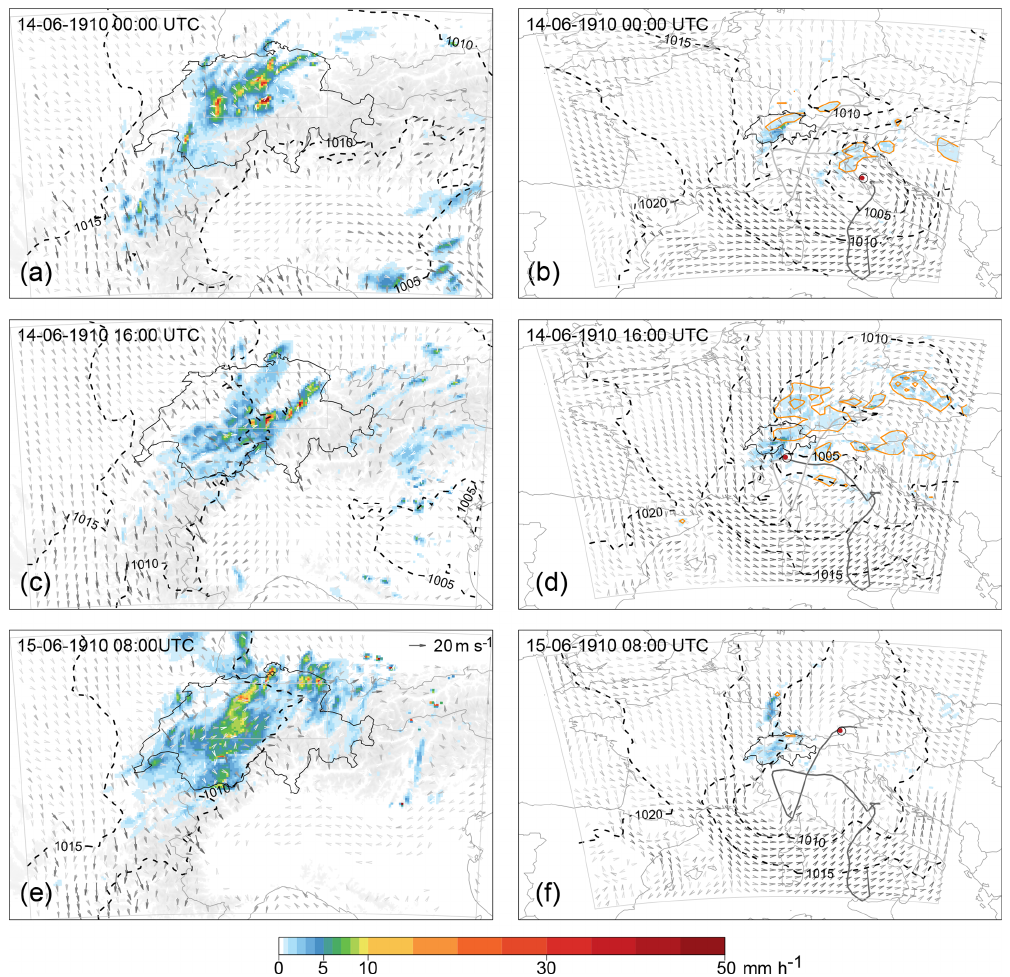
Figure 10. The 1910 event (as shown in the downscaled member #54) in the 3km WRF domain (a, c, e) and corresponding 9km WRF domain (b, d, f) and for three instances in time corresponding to heavy precipitation over northern Switzerland, that is, at (a, b) 14 June 1910 00:00UTC, (c, d) 14 June 1910 16:00UTC, and (e, f) 15 June 1910 08:00UTC. Shown are hourly precipitation (mmh − 1 ; color shade), 10m wind field (ms − 1 , light gray vectors darken with increasing velocity, see reference vector of 20ms − 1 in e ), and SLP (dashed contours, in 5hPa increments). In (b, d, f) , orange contours show the contribution of the convection parameterization to the total precipitation (contours at 2 and 5mmh − 1 ). The dark (light) gray lines in the 9km domain indicate the smoothed cyclone track starting on 13 June 1910 00:00UTC and until the shown instance. The red dot marks the cyclone center (i.e., pressure minimum) at the respective instance in